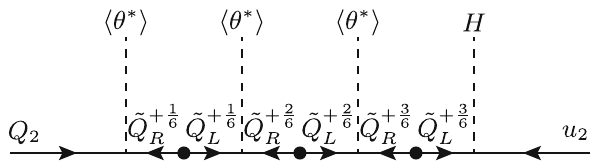
Fig. 5 Feynman diagram yielding an effective non-zero entry in ( Y ) u 22 . Each solid blob represents a mass insertion factor of 1